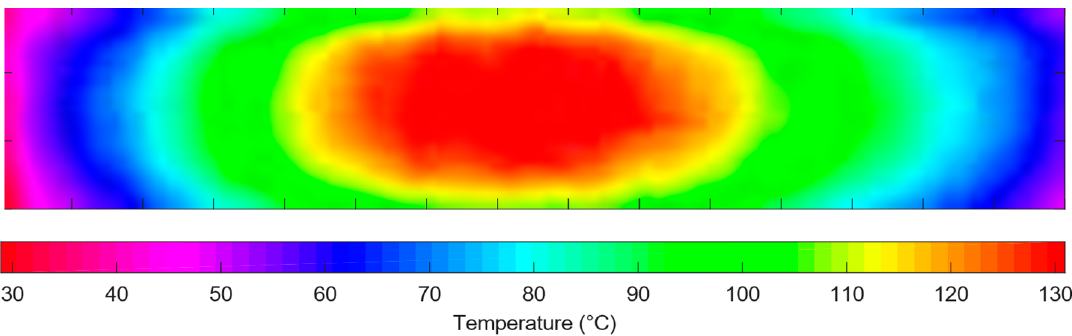
Figure 1. A thermal image of a 30 × 130 mm thin film-heating element with 3A and 6V DC applied across the element. across the